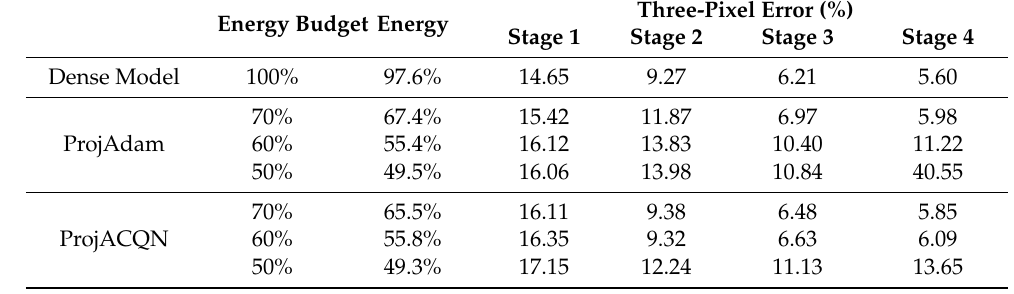
Table 1. Three-pixel error (%) and resulting energy consumption of AnyNet with 50%, 60% and 70% energy budget on KITTI-2012 dataset. A lower three-pixel error is better.